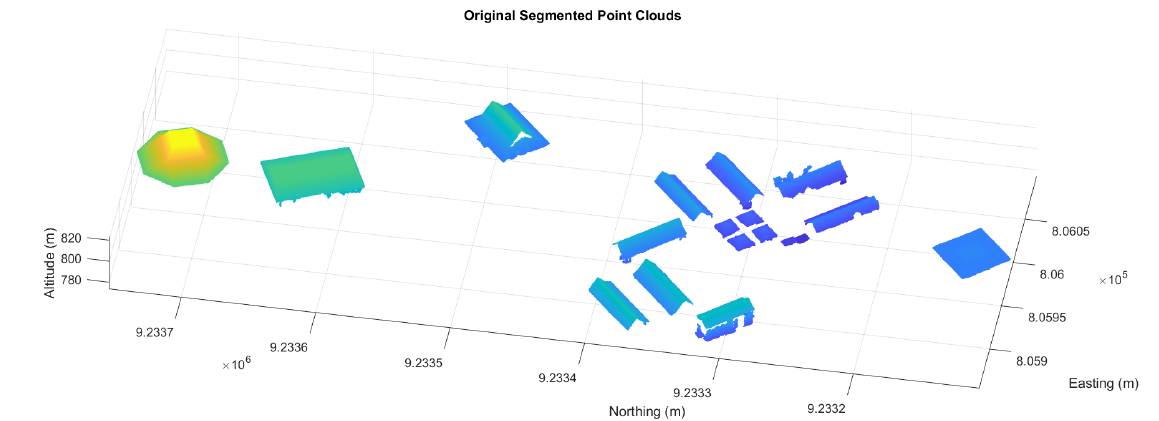
Figure 4. A global view of the segmented building roofs, before surface